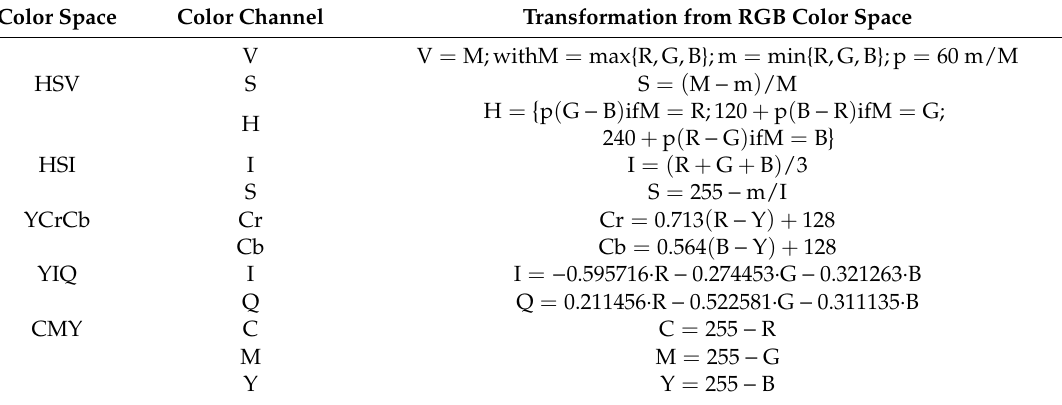
Table 1. Definition of the various color spaces used in the present work. Equations to obtain these channels from the original RGB values are also provided.